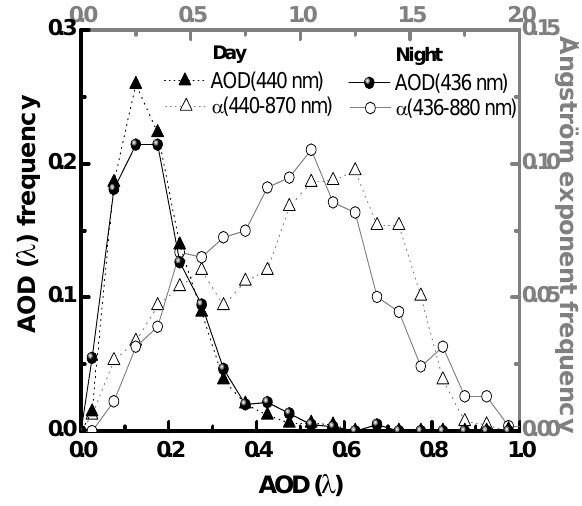
Fig. 3. Frequency histograms of AOD(440nm) and α (440–870nm) obtained at daytime and of AOD(436nm) and α (436–880nm) ob- tained at nighttime for the period